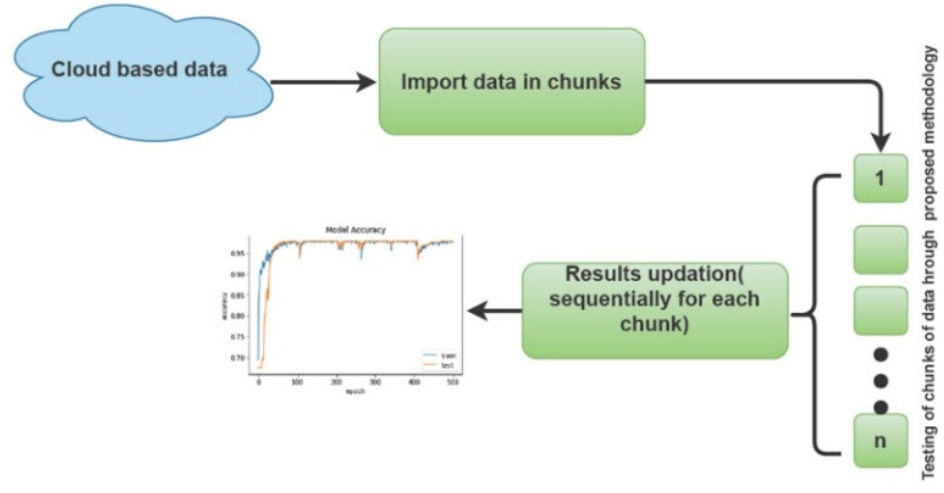
Figure 10. Real-time data processing using optimized proposed model CNN-Bi-LSTM.